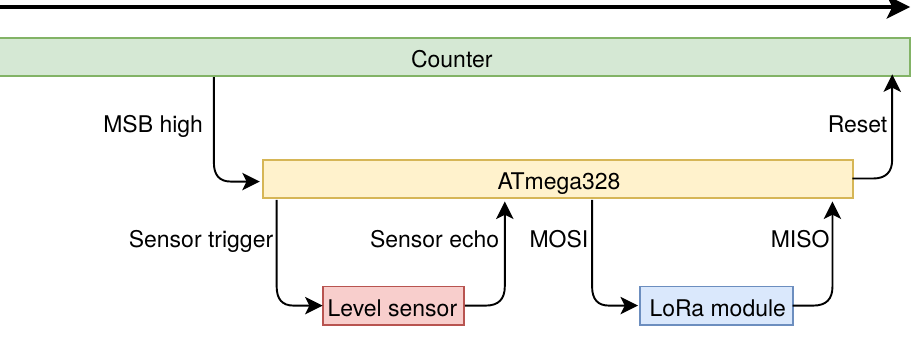
Figure 6. Flow chart of the energy-saving